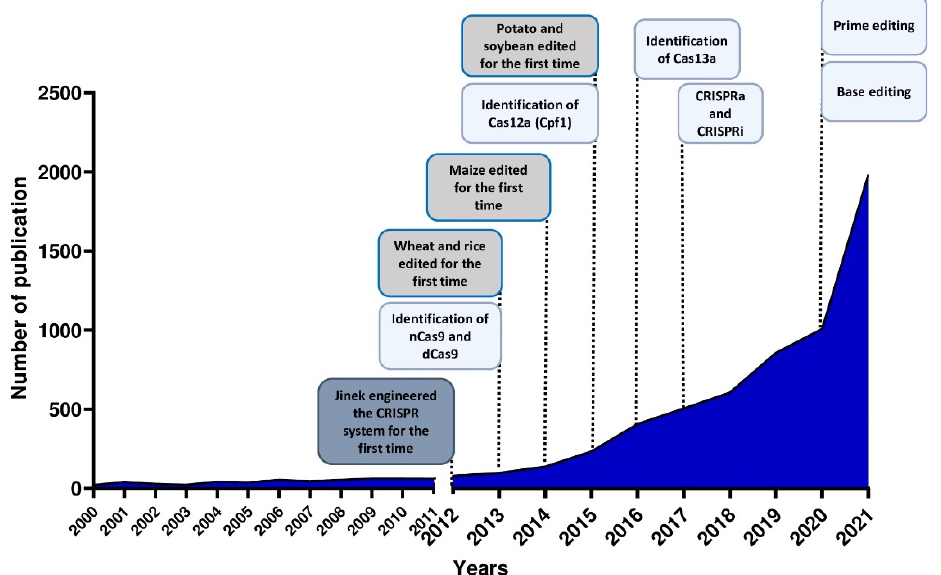
Figure 2. Number of publications in plant breeding using CRISPR systems and major achievements in the last 10 years.